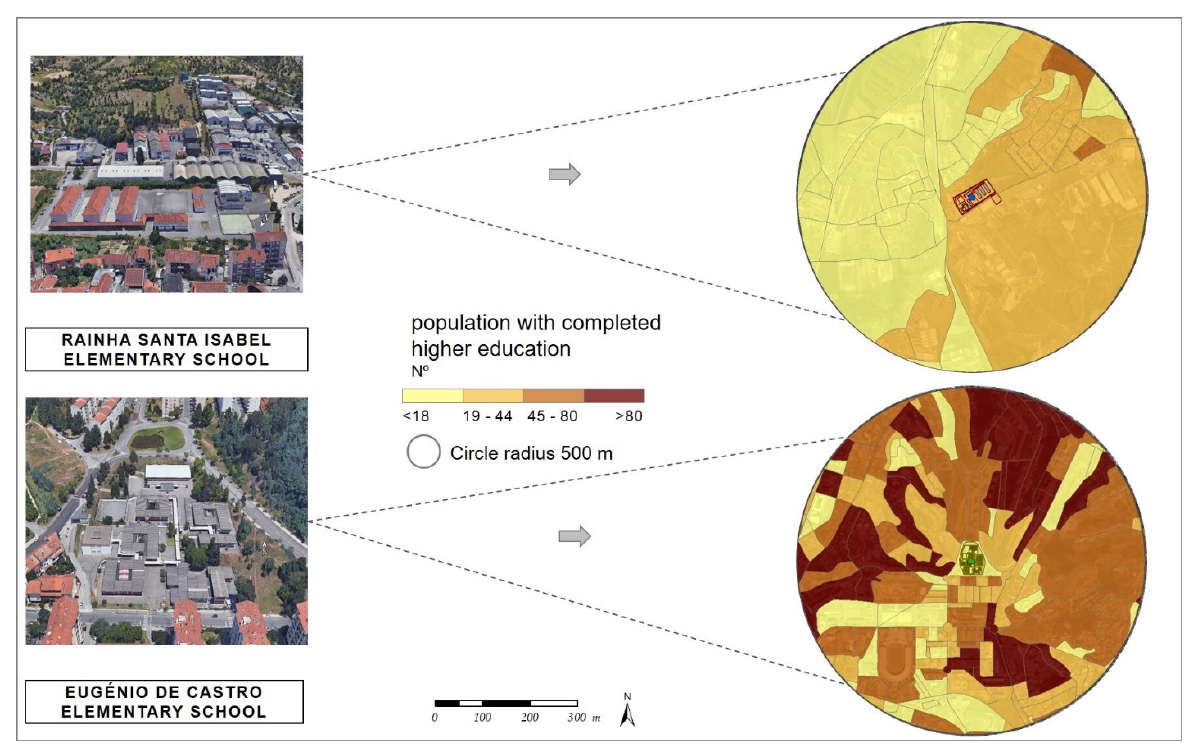
Figure 3. Demographic context of the territories surrounding the partner schools.